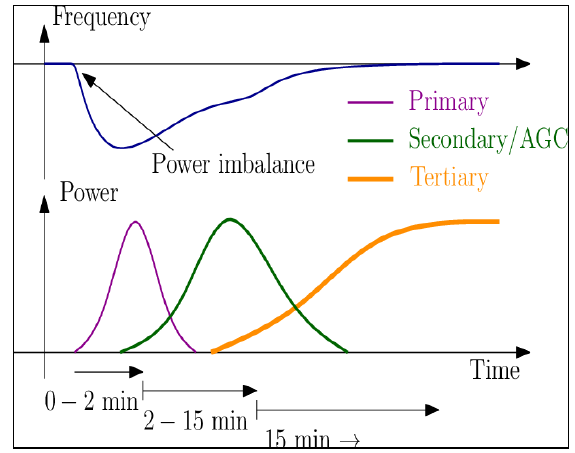
Figure 11. Activation of the primary, secondary (AGC) and tertiary control after the imbalance on the